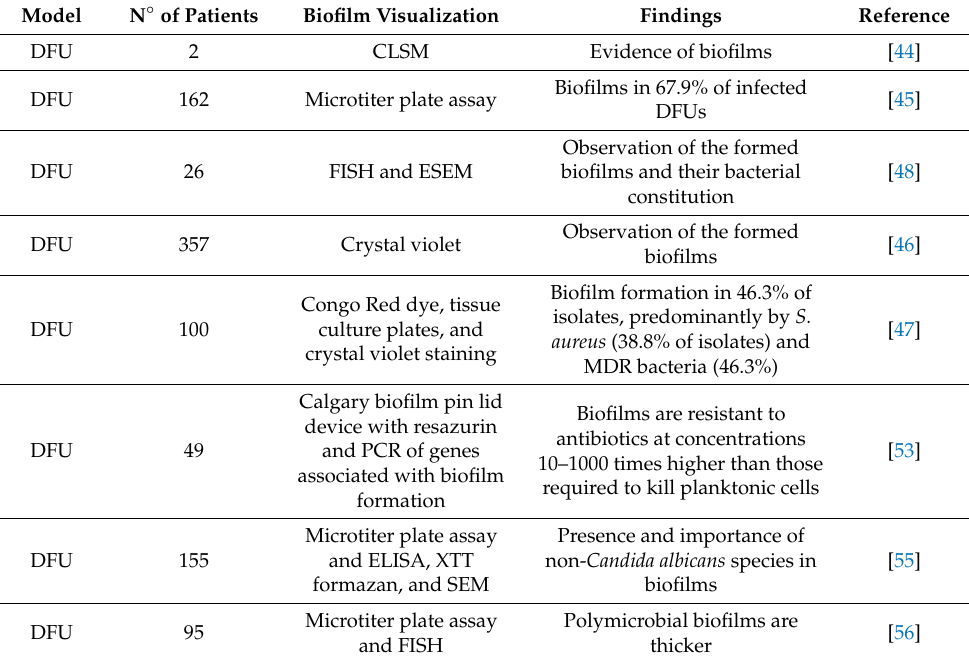
Table 2. Examples of biofilm studies in clinical human